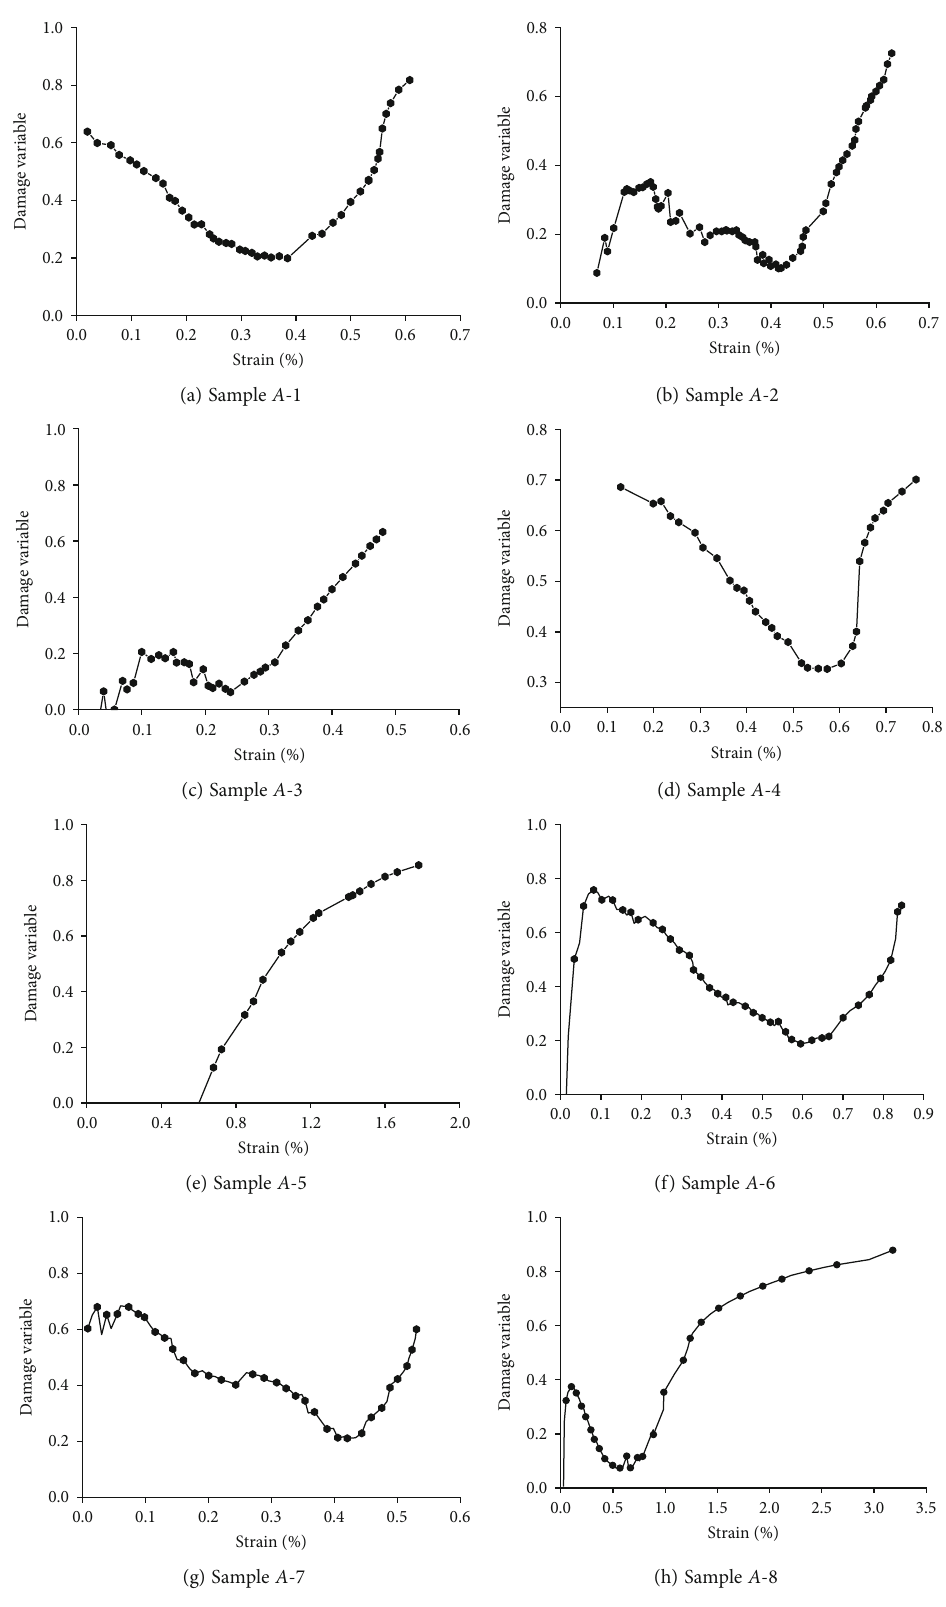
Figure 4: Damage variables based on elastic